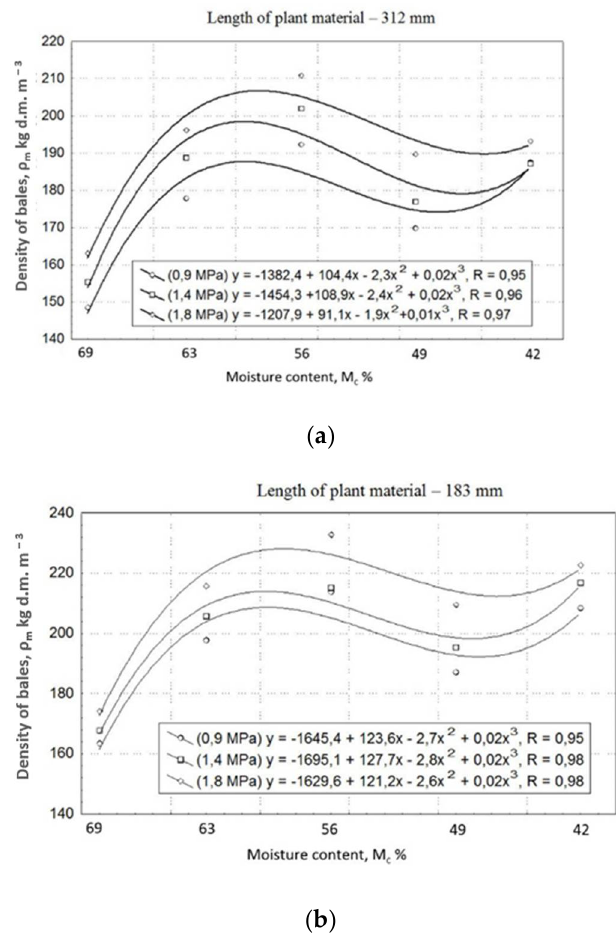
Figure 12. Relationship between balage density ( ρ m ) and plant material moisture content for ( a ) plant material with a length (L m ) of 312 mm and ( b ) chopped plant material at L m = 183 mm.